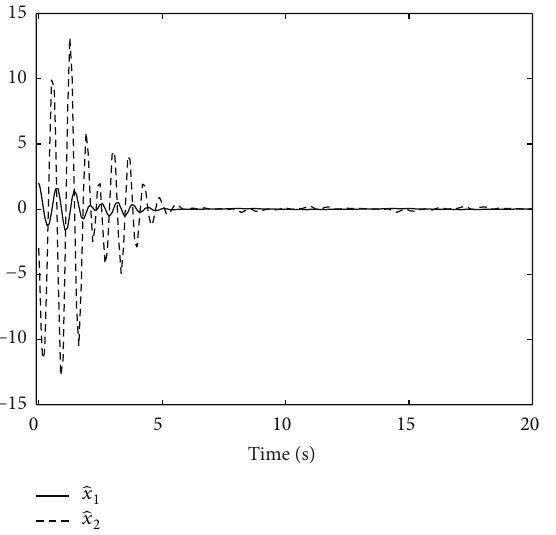
Figure 5: The trajectory of high-gain 𝐿